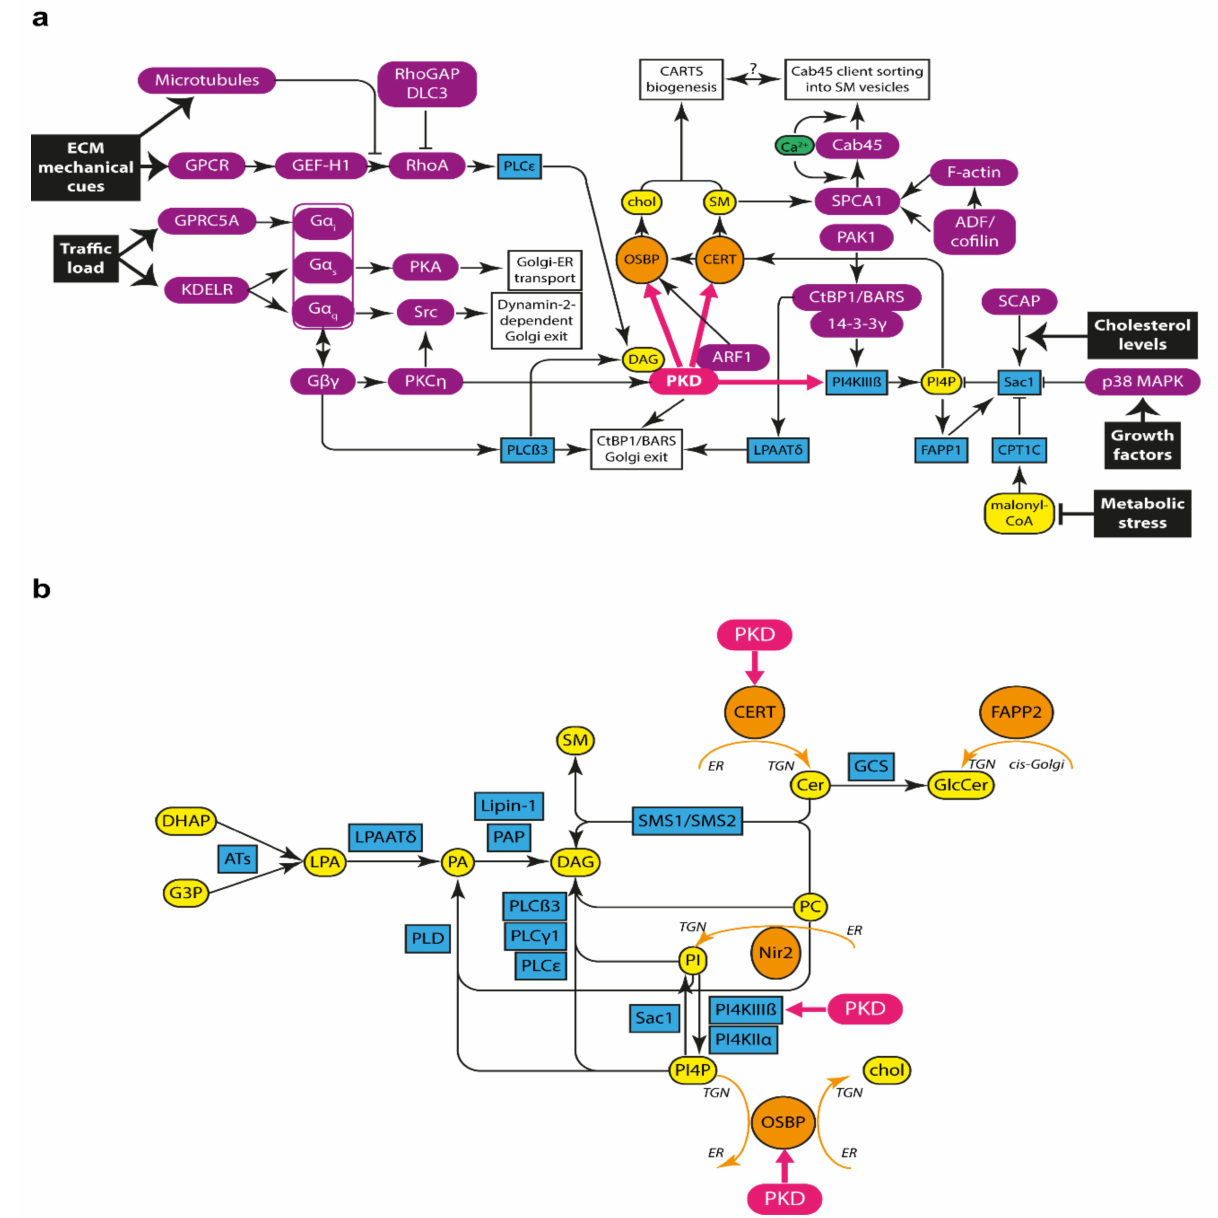
Figure 2. Lipid and protein signaling pathways that regulate Golgi lipid homeostasis and TGN-to-PM transport. ( a ) Sig- naling pathways leading to the activation of PKD (in pink) for the regulation of transport carrier biogenesis at the TGN. LTPs shown in orange, lipids in yellow, lipid metabolizing enzymes in blue, and other protein in dark violet. Upstream signals leading to regulation of the different pathways are shown as black text boxes, and the different Golgi export routes are depicted as white text boxes. ( b ) Lipid metabolic routes involved in DAG synthesis and Golgi lipid homeostasis. PKD shown in pink, LTPs shown in orange, lipids in yellow, lipid metabolizing enzymes in blue. Orange arrows indicate non-vesicular lipid transport, and pink arrows represent PKD-mediated phosphorylation. ATs: acyltransferases; cer: ceramide; CERT: ceramide transport protein; chol: cholesterol; DAG: diacylglycerol; DHAP: dihydroxyacetone-3-phosphate; FAPP2: four-phosphate adaptor protein 2; GlcCer: Glucosylceramide; GCS: GlcCer synthase; G3P: glycerol-3-phosphate; LPA: lysophosphatidic acid; LPAAT: LPA acyltransferase; OSBP: oxysterol-binding protein; PA: phosphatidic acid; PAK1: p21-activated kinase 1; PAP: PA phosphohydrolase; PC: phosphatidylcholine; PI: phosphatidylinositol; PI4K: PI 4-kinase; PI4P: PI 4-phosphate; PKA: protein kinase A; PKC: protein kinase C; PKD: protein kinase D; PLC: phospholipase C; PLD: phospholipase D; SM: sphingomyelin; SMS: SM synthase. See text for